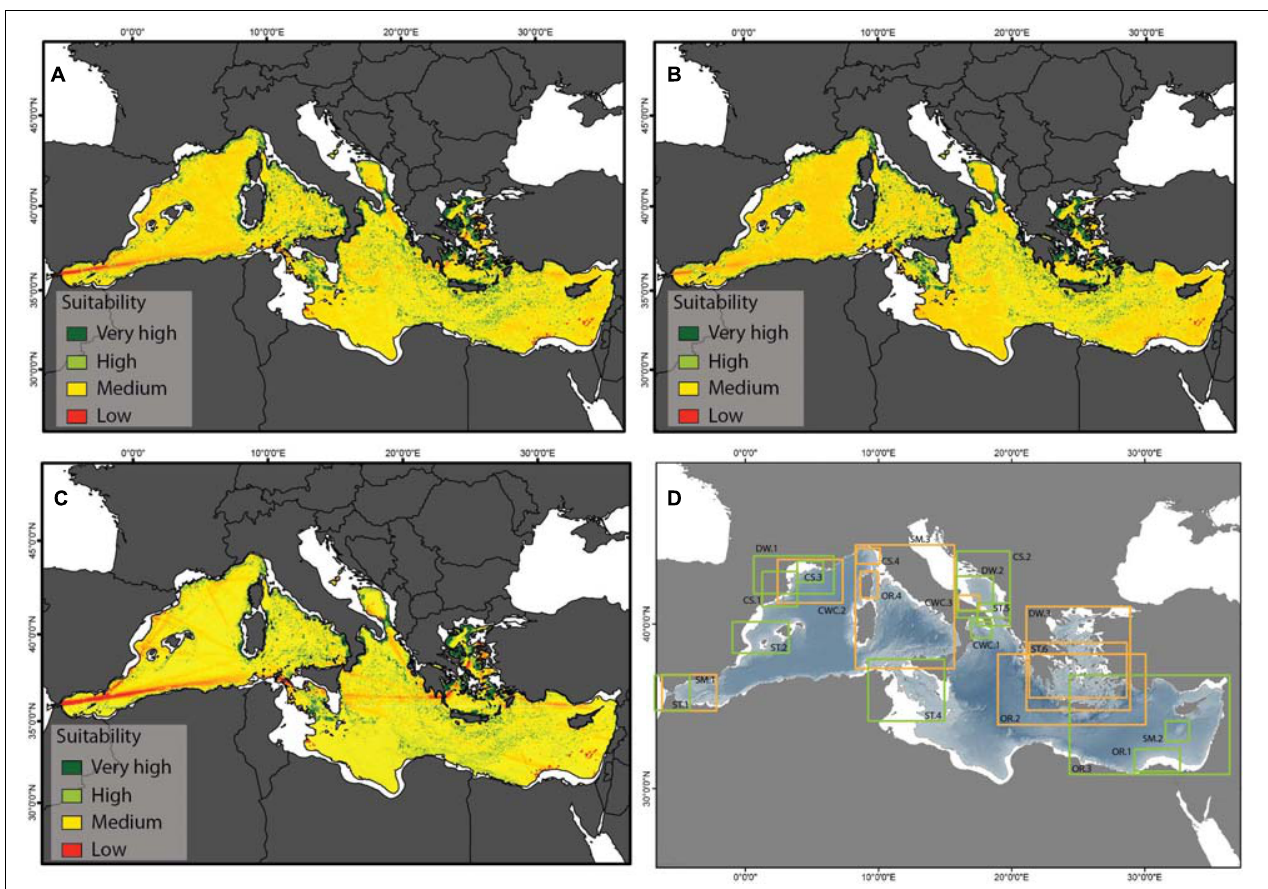
FIGURE 3 | Results of Multi-Criteria Decision Analysis (MCDA) outputs (A–C) and of expert evaluation (D) : (A) MCDA output for Scenario A; (B) MCDA output for Scenario B; (C) MCDA output for Scenario C; (D) potential key areas for conservation highlighted by rectangles and identified by the area’s code, as in Table 3 . The green rectangles identify the areas finally selected for priority monitoring and conservation ( Table 3 ), whereas the orange ones are Putative Priority Areas (PPA) not selected as they fell below the 70 scores threshold ( Supplementary Table 5 ). Areas shallower than 200 m depth are depicted in